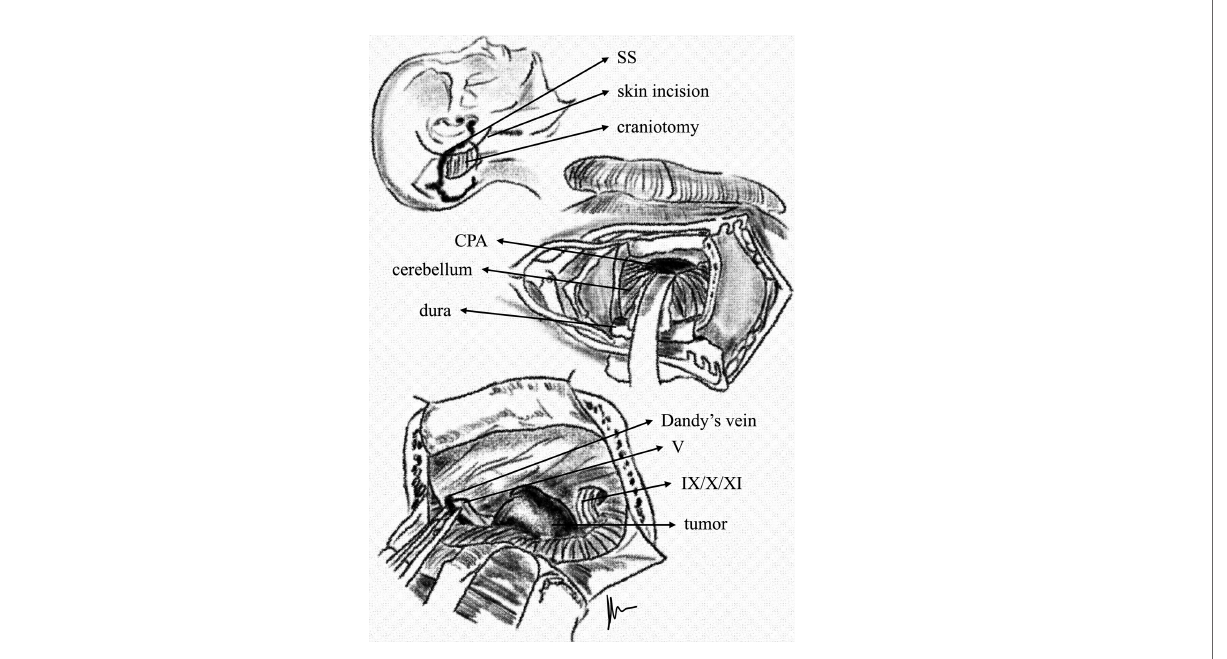
FIGURE 1 | C-shaped incision used in the RSA. After craniotomy and retraction of the cerebellum, the tumor becomes visible within the cerebellopontine angle. The anterior edge of craniotomy is placed immediately behind the sigmoid sinus and just inferior to the lower margin of the transverse